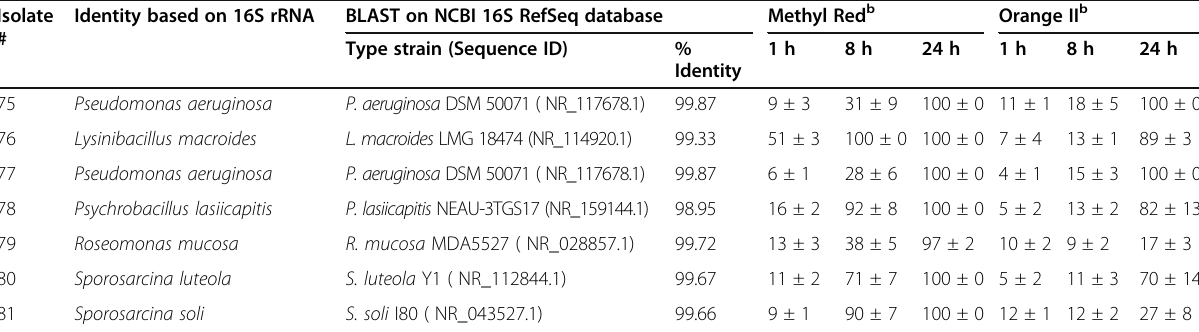
a The data show the mean of degradation (%) ± SD from repeated triplicated assay using 96-well microphates b 100 μ M Orange II and 100 μ M Methyl Red were used in the degradation assay, except that 50 μ M and 25 μ M Methyl Red were used for isolates #4 and #16, respectively and 12.5 μ M Methyl Red was used for isolates #12 and #20. Absorbance wavelengths for Methyl Red and Orange II were 430 nm and 475 nm, respectively